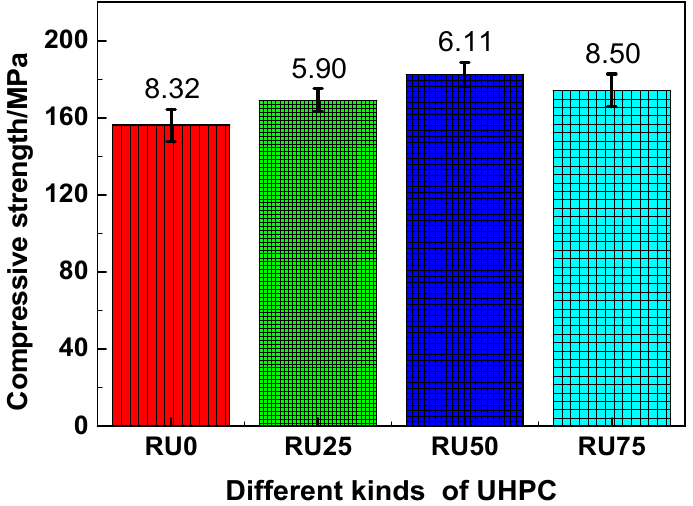
Figure 5. The compressive strength of RS-UHPC with different contents of GO.